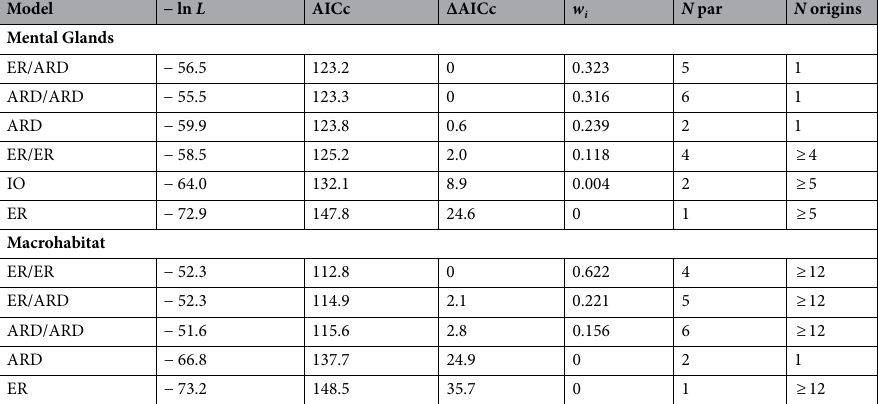
Table 2. The fit of alternative models of mental gland (MG) evolution in turtles, based on Akaike scores and weights derived from the log likelihoods of the models. N par. indicates the number of estimated transition parameters. N origins refers to the number of independent origins of MGs or terrestriality inferred by the models. ER—all transition rates equal; ARD—distinct rates for all transitions between states (“all rates different”); IO—enforced independent origins of MGs in Testudinoidea; ER/ER—model using the generalized hidden Markov process, consisting of two ER transition matrices; ARD/ARD—hidden Markov model with two ARD transition matrices; ER/ARD—hidden Markov model with one ARD and one ER transition matrices.